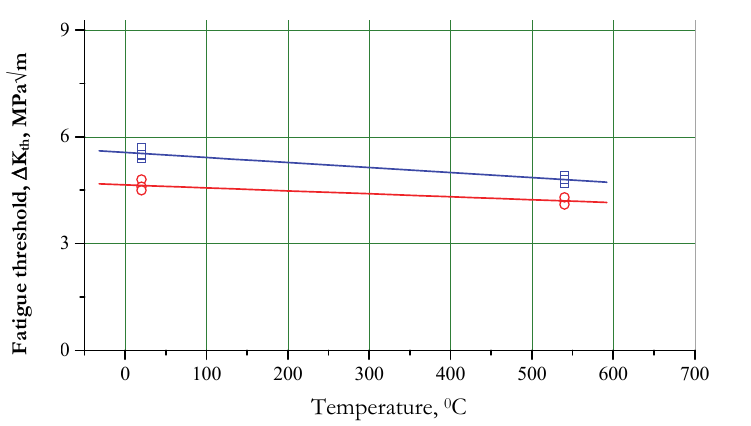
Figure 5: Fatigue threshold ΔK th vs. temperature in